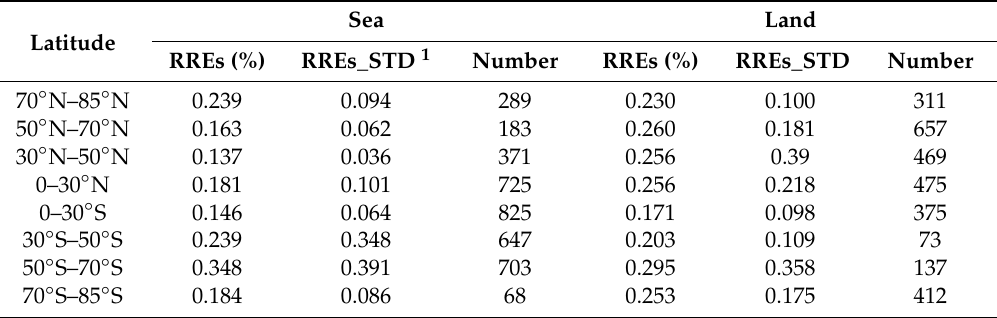
Table 2. The September 2016 monthly mean RREs of AC-IPDA lidar changes with latitudes. Sea Land Latitude RREs (%) RREs_STD 1 Number RREs (%) RREs_STD Number 70 ◦ N–85 ◦ N